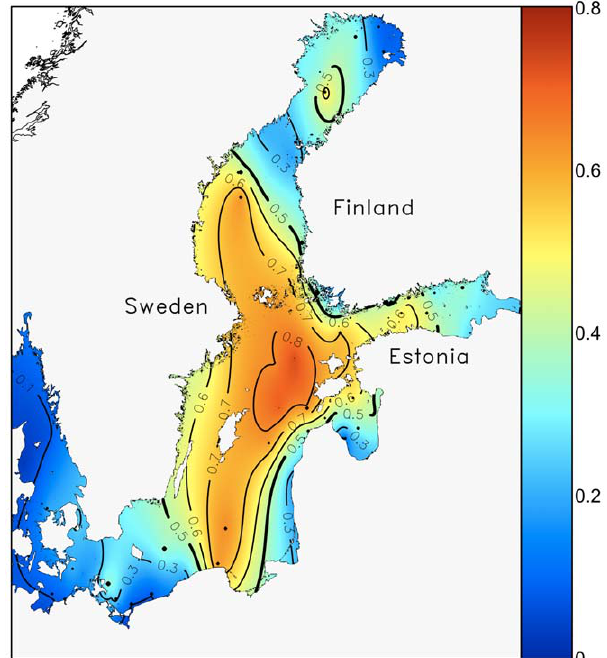
Figure 4. Spatial variability in the proportion of dinoflagellates interpolated with ordinary kriging. The thick contour line separates dinoflagellate dominance ( . 0.5) and diatom dominance ( ,